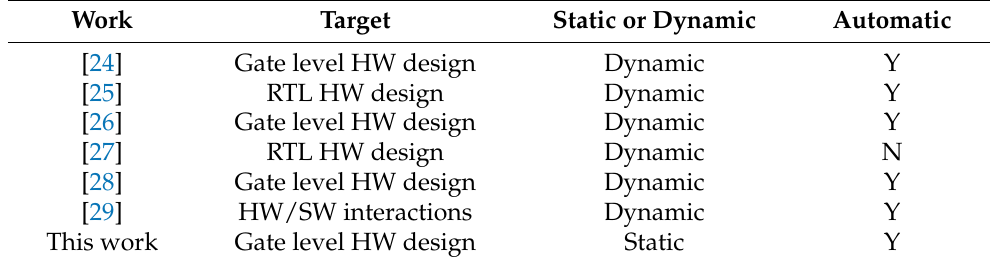
Table 1. Summary of formal methods in hardware